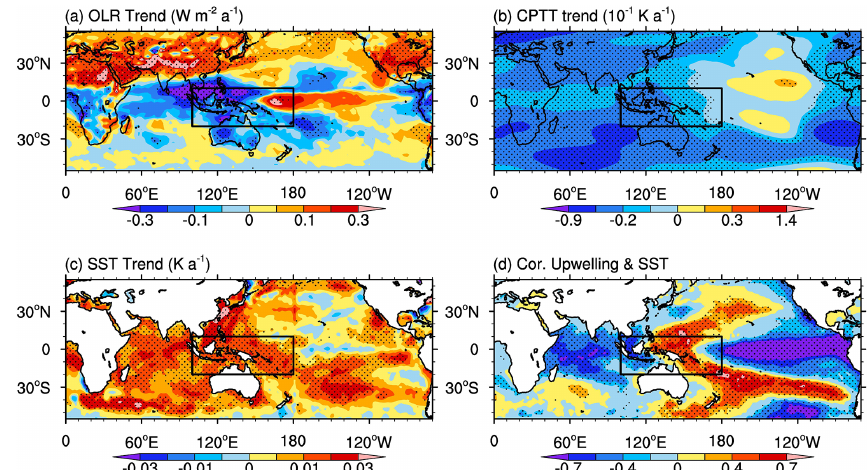
Figure 4. Trends of (a) observed outgoing longwave radiation (OLR; Wm − 2 a − 1 ) provided by NOAA during 1974–2017. (b) Cold-point tropopause temperature (CPTT; 10 − 1 Ka − 1 ) derived from JRA55 data and (c) SST (Ka − 1 ) derived from HadISST during 1958–2017 in NDJFM. (d) The correlation coefficients between the intensity of the upward motion at 150hPa over the TWP and SST in NDJFM during 1958–2017 are shown with the linear trends removed. The trends and correlation coefficients over the dotted regions are statistically significant at the 95% confidence level. The black rectangles denote the TWP region (20 ◦ S–10 ◦ N, 100–180 ◦